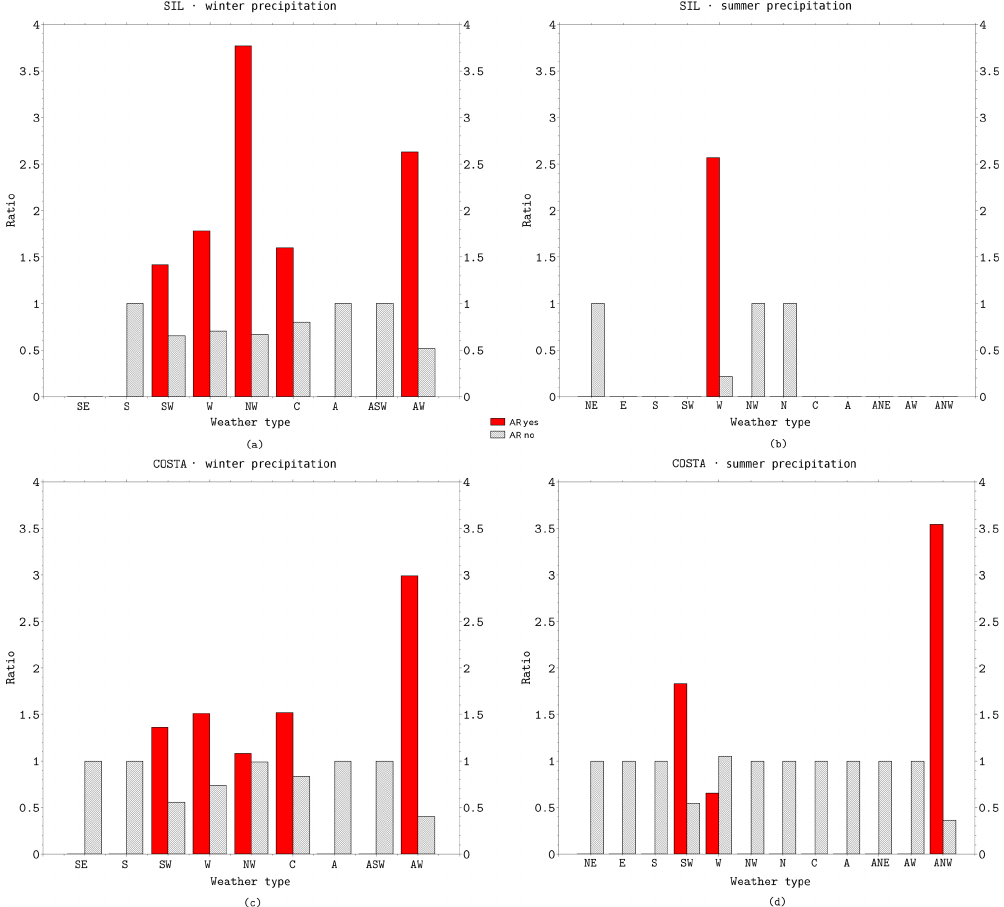
Figure 5. Same as Fig. 4 but with precipitation